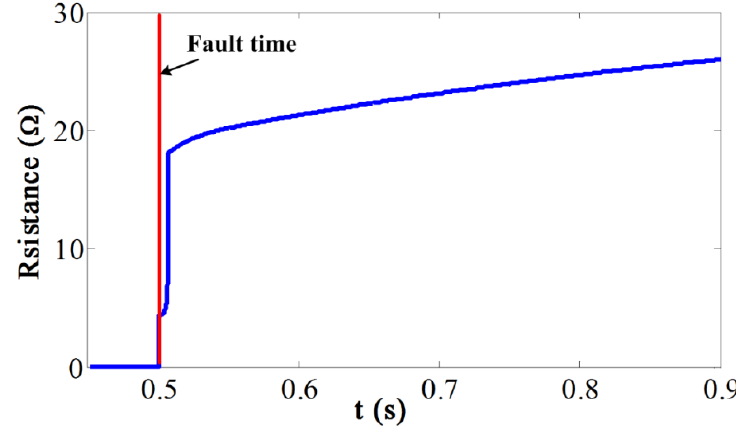
Figure 2. Variation of the resistance of the